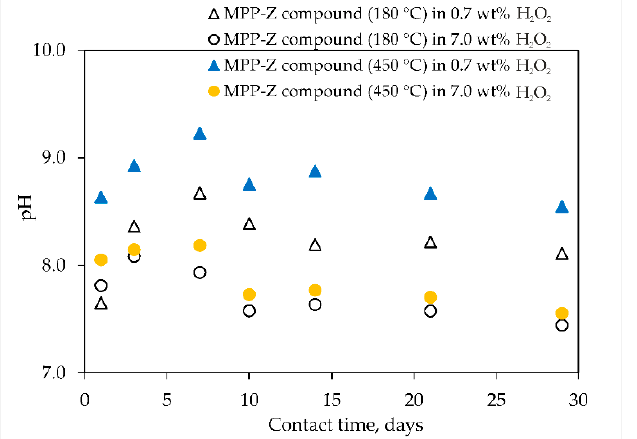
Figure 8. The pH values of solutions after leaching of samples of MPP-Z compounds in hydrogen peroxide solutions.